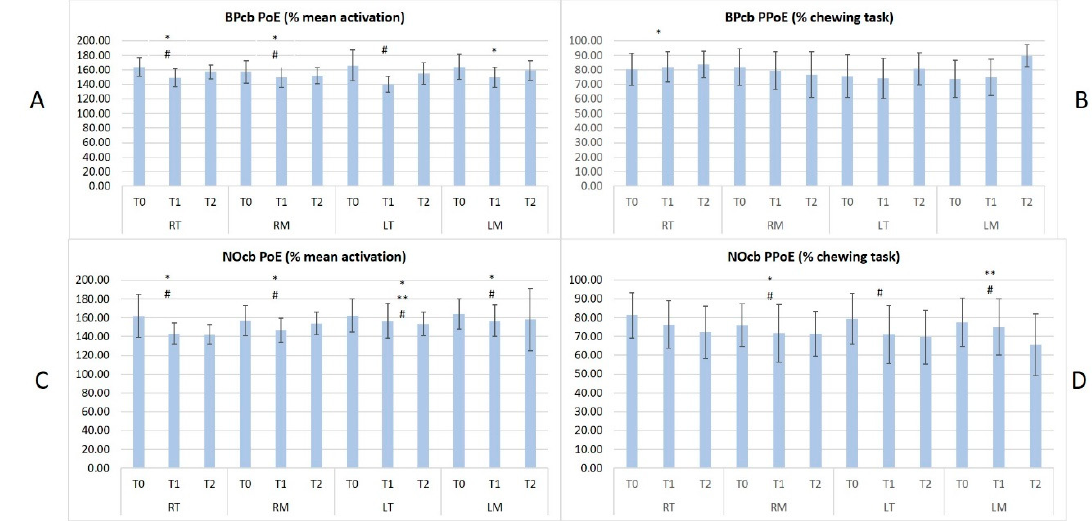
Figure 3. the results of a paired T Test (p < 0.05) at T0, T1 and T2 in both BPcb in the upper graphs (3A and 3B), and in NOcb (in the lower graphs (3C and 3D)). In graphs 3A and 3C the y-axis represents the Peak of Envelope (PoE in % of mean activation) in terms of mean and standard deviation; in graphs 3B and 3D the y-axis represents the Position of Peak of Envelope (PPoE % of chewing task) in terms of mean and standard deviation. On the x-axis of all the graphs, the names of the muscles are reported: RT (Right Temporalis), RM (Right Masseter), LT (Left Temporalis) and LM (Left Masseter) and for each muscle, the acquisition time is reported (T0, T1 and T2). The significant results of paired T Test (p < 0.05) between different acquisitions (T0, T1 and T2) are shown with different symbols as follows: T0 vs T1, p < 0.05 = *; T1 vs T2, p < 0.05 = **; T0 vs T2, p < 0.05= #.